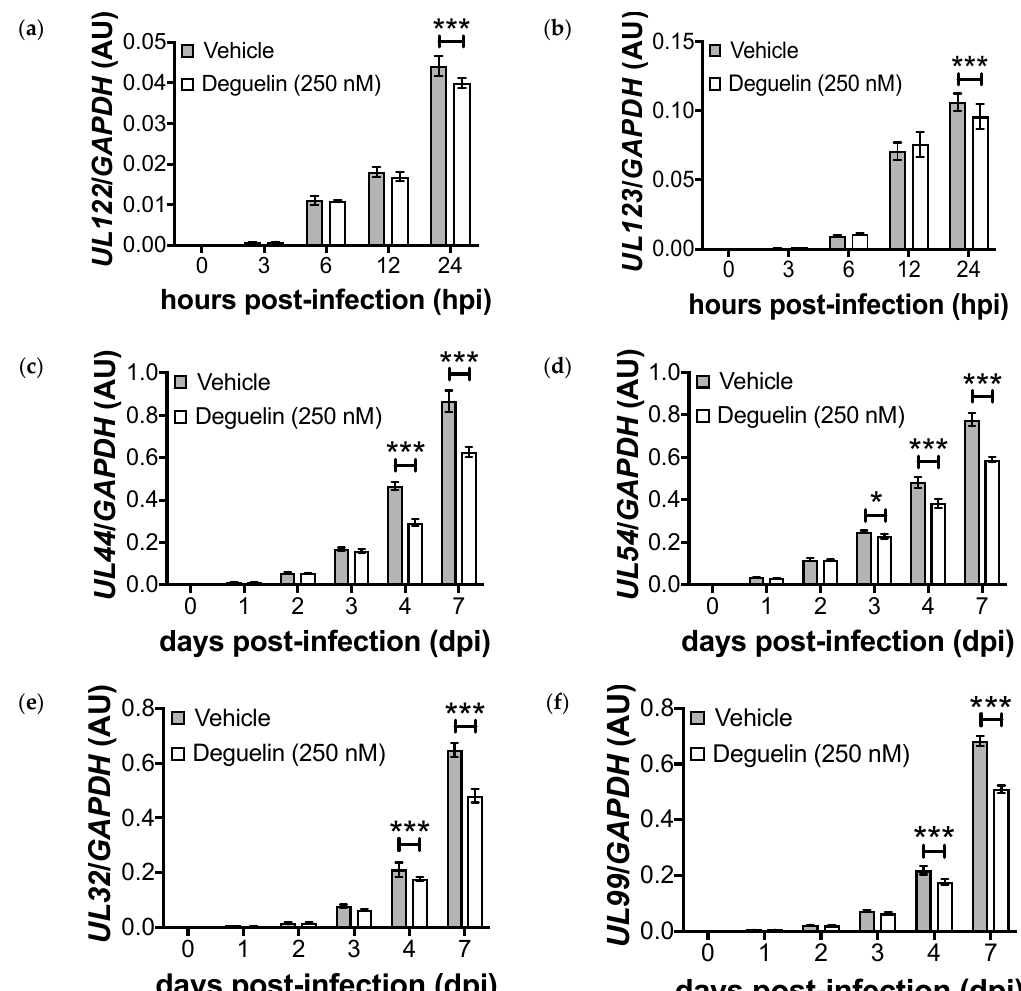
Figure 5. Treatment of HCMV infected fibroblasts with deguelin decreases IE, E, and L gene transcripts. NuFF-1 cells were treated with vehicle (DMSO) or deguelin (250 nM) for 1 h, after which cultures were infected with UL99 eGFP (moi = 1.0). Total RNA was collected at the indicated time points. Viral transcripts were assessed by RTqPCR using the following primers: ( a ) UL123 and ( b ) UL122 (IE); ( c ) UL44 and ( d ) UL54 (E); ( e ) UL32 and ( f ) UL99 (L). Each sample was analyzed in triplicate and normalized to cellular GAPDH . Error bars represent the standard deviation of three technical replicates. Replicate assays were performed ( n = 3), and a representative biological replicate is shown in each panel. AU = arbitrary units. Statistical significance was calculated by two-way ANOVA, * p < 0.05, ** p < 0.005, *** p < 0.0001.